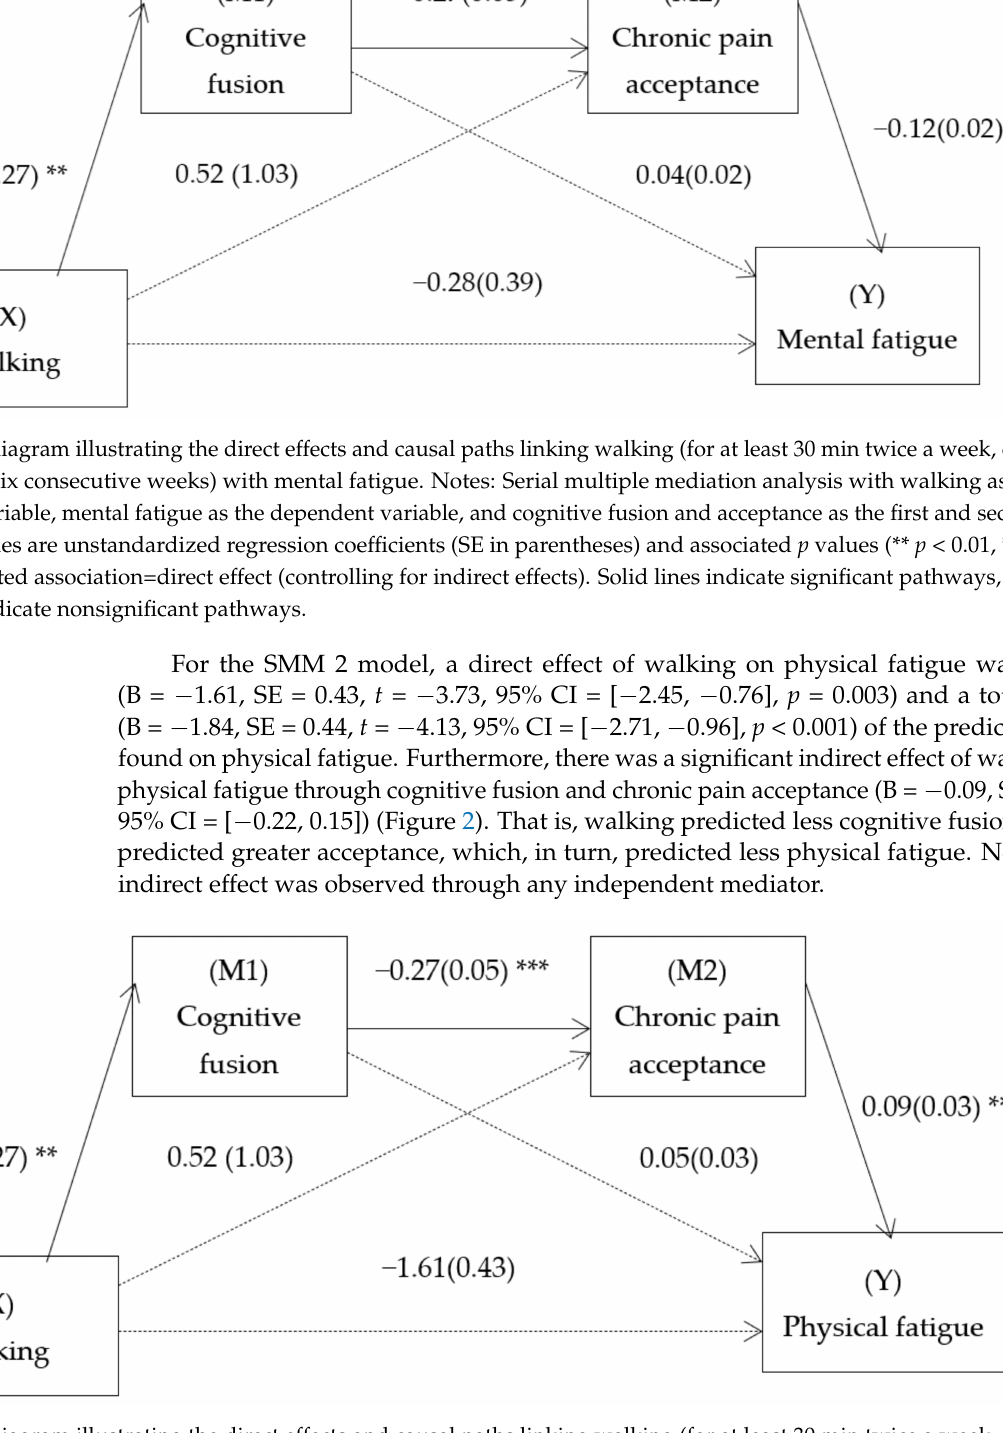
Figure 2. Path diagram illustrating the direct effects and causal paths linking walking (for at least 30 min twice a week, over a minimum of six consecutive weeks) with physical fatigue. Notes: Serial multiple mediation analysis with walking as the independent variable, physical fatigue as the dependent variable, and cognitive fusion and acceptance as the first and